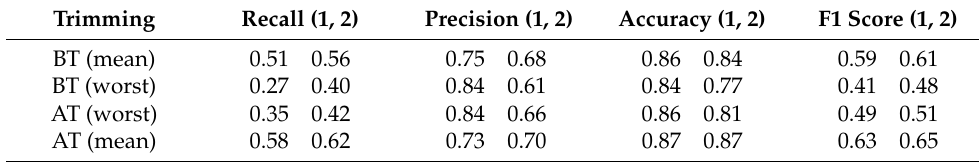
Table 5. Four performance results of LSTM with training data type [Genre*ATV]. Trimming